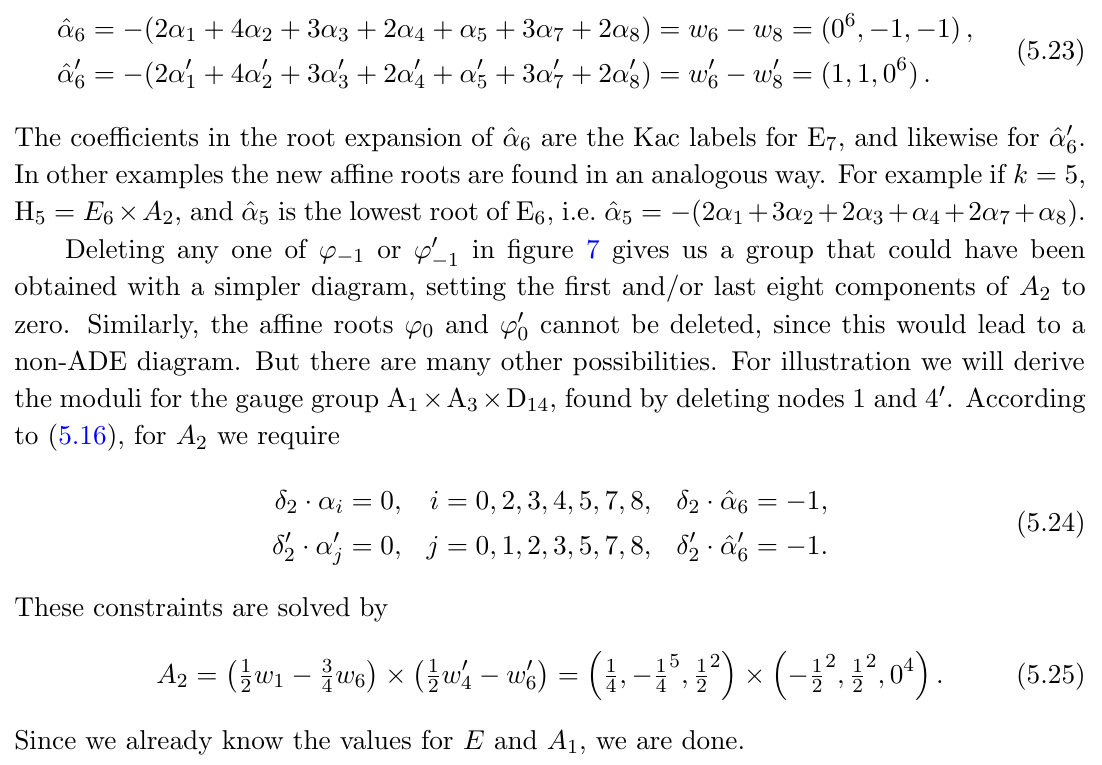
Figure 7. Extended diagram for double breakings corresponding to the choice A 1 = 1 E = E 1